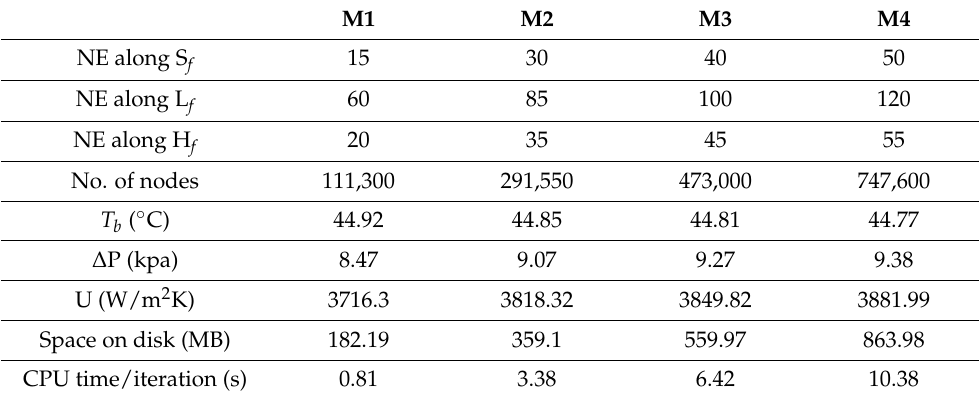
Table 2. Mesh independence study of a mini-channel with t f and S f equaling 0.5 and 1 mm, respectively.